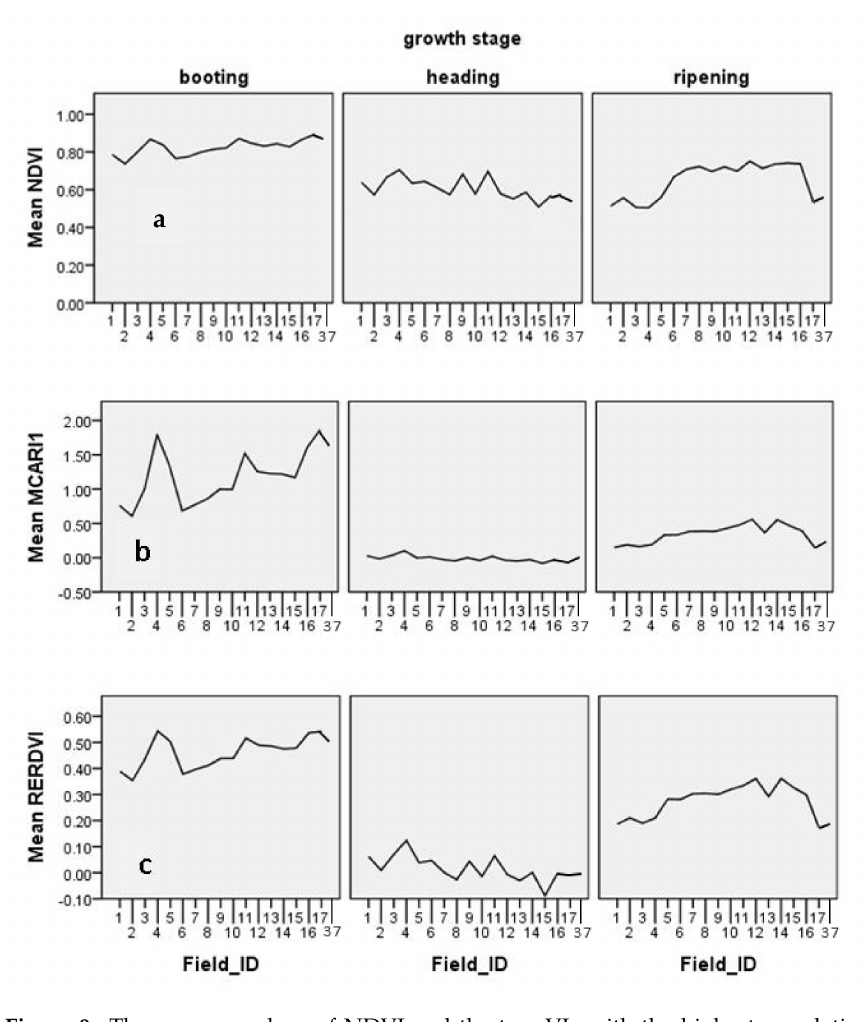
Figure 9. The average values of NDVI and the two VIs with the highest correlation with yield (MCARI1 for Gladio and RERDVI for Ronaldo) per plot and for the three dates ( a = 6 July, b = 21 July, c = 30